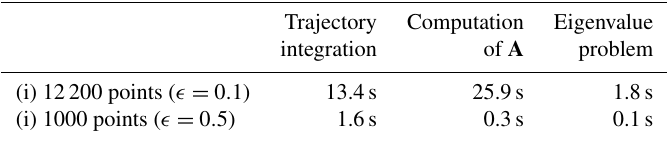
Table 1. Computation times (in